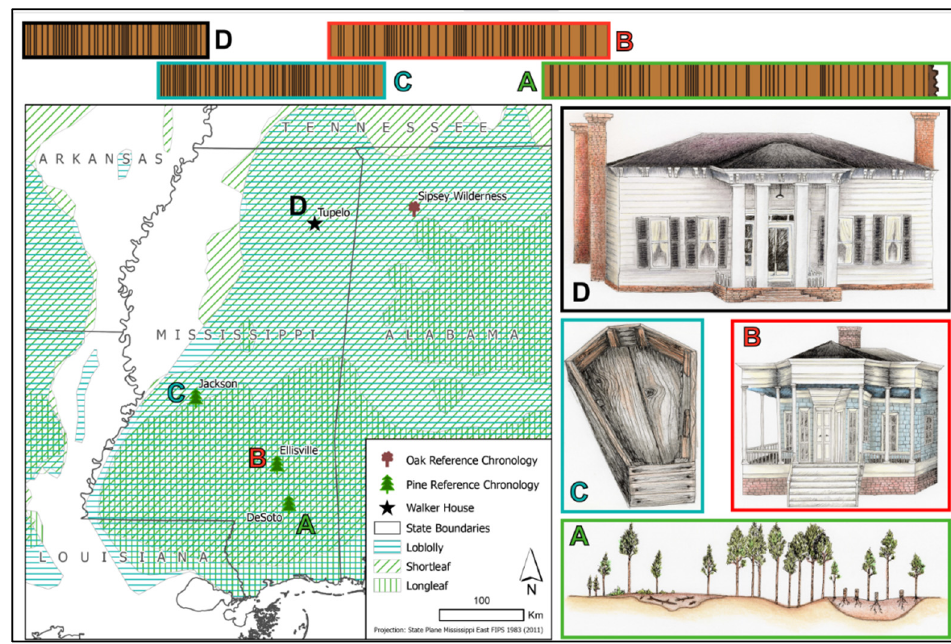
Figure 4. Map of the Walker House study site (star; D ), and the locations/illustrations for material that contributed to the cross-dating and development of the longleaf pine latewood reference chronology (points A – C [32,12,33]). The longleaf pine chronology is comprised of living trees and remnant stumps ( A ; [32]), material extracted from the Deason House in Ellisville, MS ( B ; [13]), coffin material escavated near Jackson, MS ( C ; [33]), and material extracted from the Walker House ( D ; this study). This map also shows the historic range of longleaf pine (vertical hachures), shortleaf pine (horizontal hachures), and loblolly pine (cross hachures) [34].